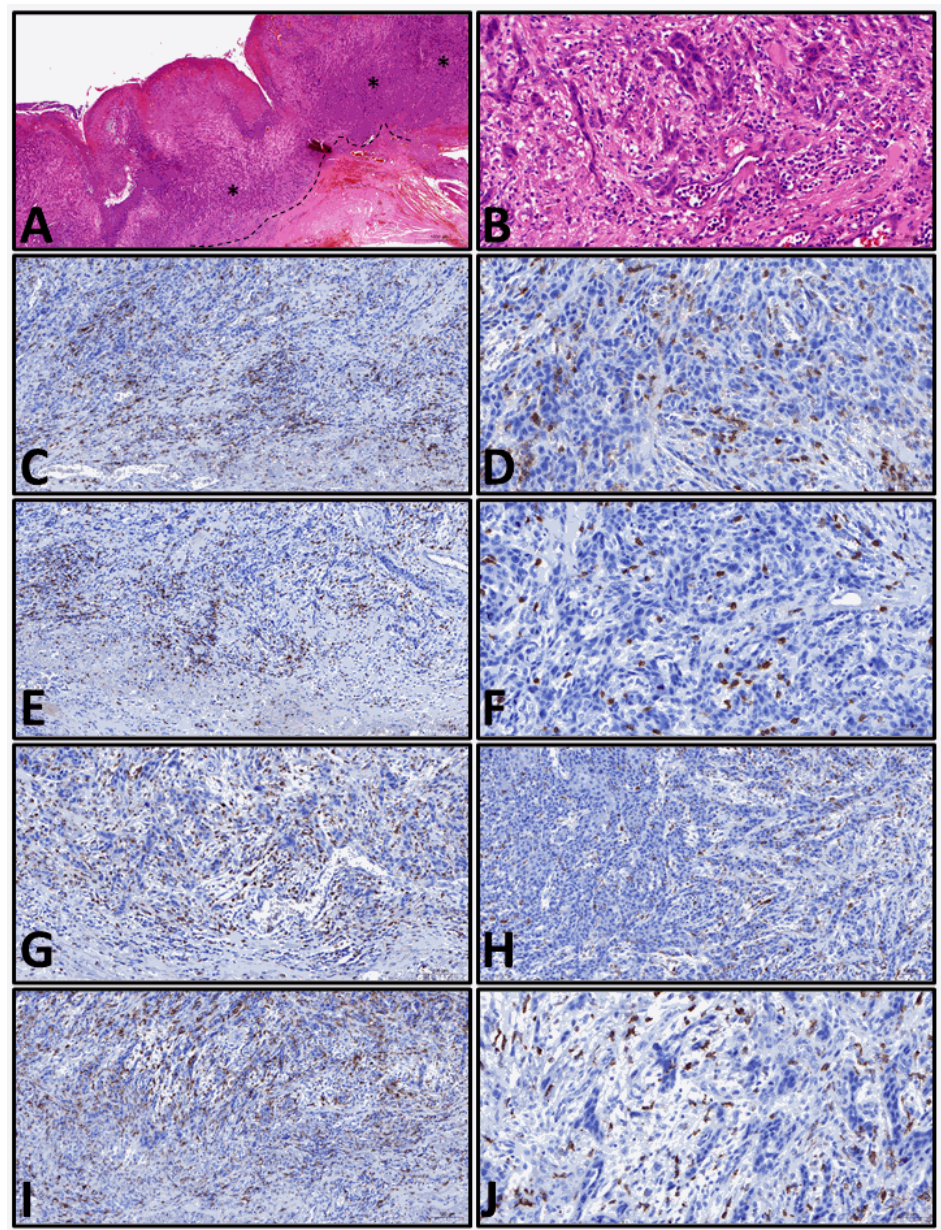
Figure 1. Examples of the evaluated cases. ( A ): Overview of a tissue sample, H.E. 40×